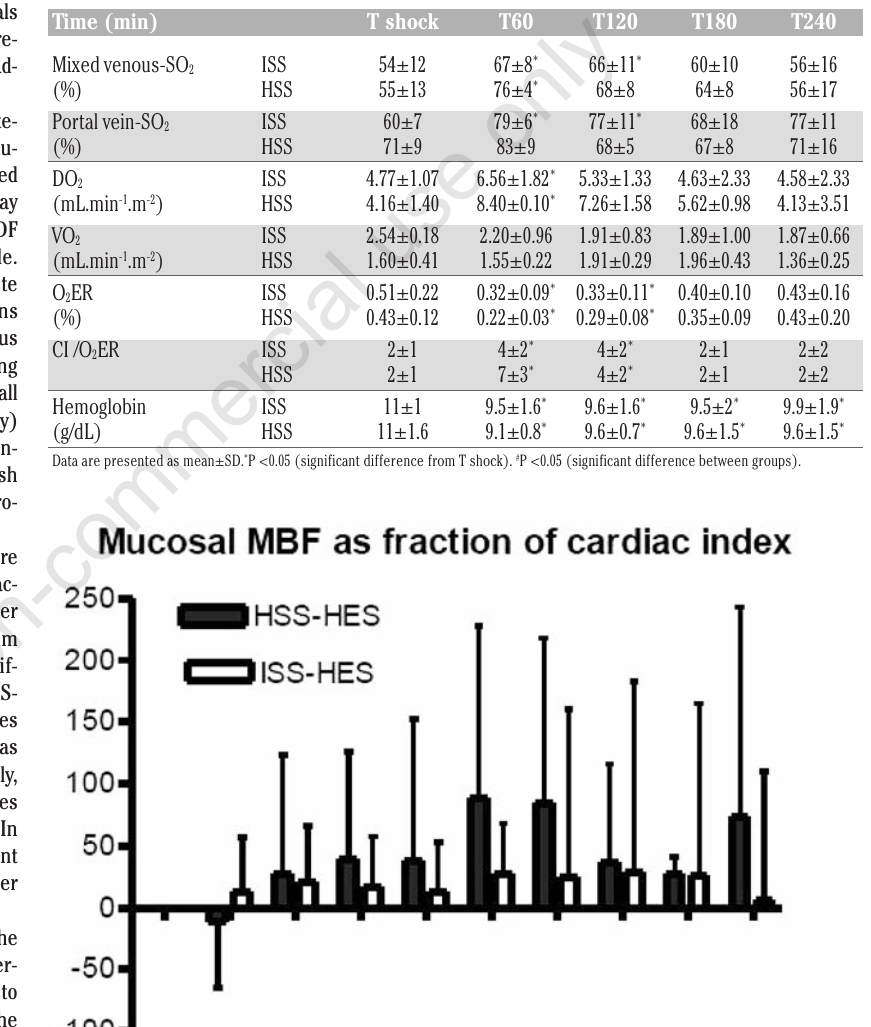
Table 4. Variables of oxygenation during fluid administration. After induction of peri- tonitis, septic shock took place at T shock, when pigs were resuscitated during 240 min either with (HSS-HES) hypertonic saline 7.2%/ hydroxyethyl starch or (ISS-HES) iso- tonic saline 0.9%/hydroxyethyl starch. DO 2 =oxygen delivery, VO 2 =mesenteric oxygen consumption, ER=oxygen extraction, SO 2 =oxygen saturation, CI=cardiac index.